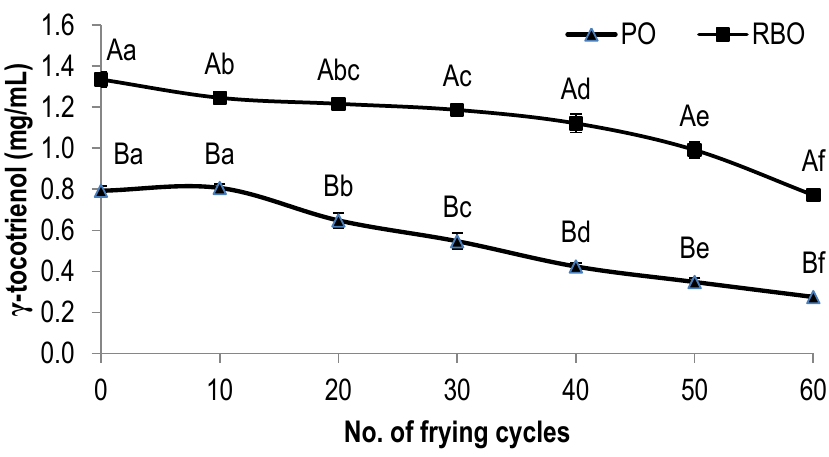
Figure 3. The degradation of γ-tocotrienol in palm oil and rice bran oil during deep-frying. The values given are means ± standard deviation of a triplicate analysis. The values marked with the same letters are not significantly different at p < 0.05 analyzed using the Duncan multiple range test. A,B, the values with different capital letters indicate a significant difference between the type of oil at p < 0.05. a,b, the values with different small letters indicate a significant difference between frying cycle numbers at p <